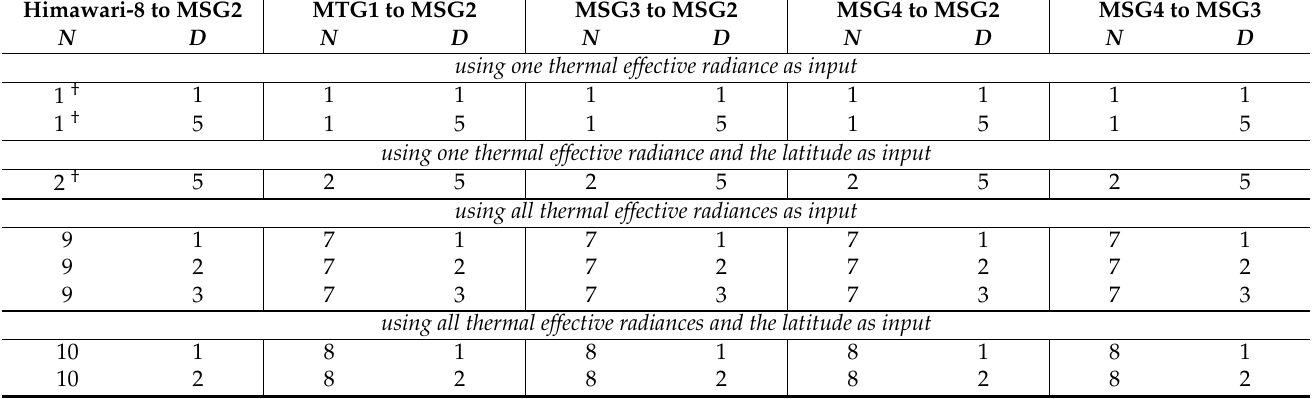
Table 1. Polynomials with different numbers of input channels ( N ) and degrees ( D ) trained as SBAFs in this study. For the SBAFs mapping Himawari-8/AHI to MSG2/SEVIRI marked by † , the functions use both thermal channels close to 10.8 µ m of Himawari-8/AHI to reproduce the 10.8 µ m measurement of MSG/SEVIRI, as there is no preferred candidate available. Thus, N is effectively increased by one in these